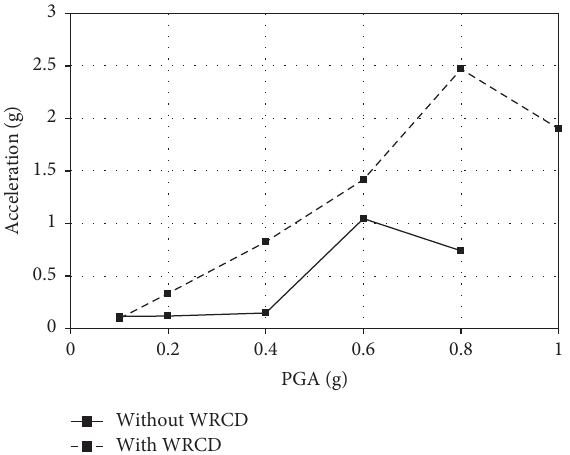
Figure 8: Maximum acceleration of 2# fxed pier top.